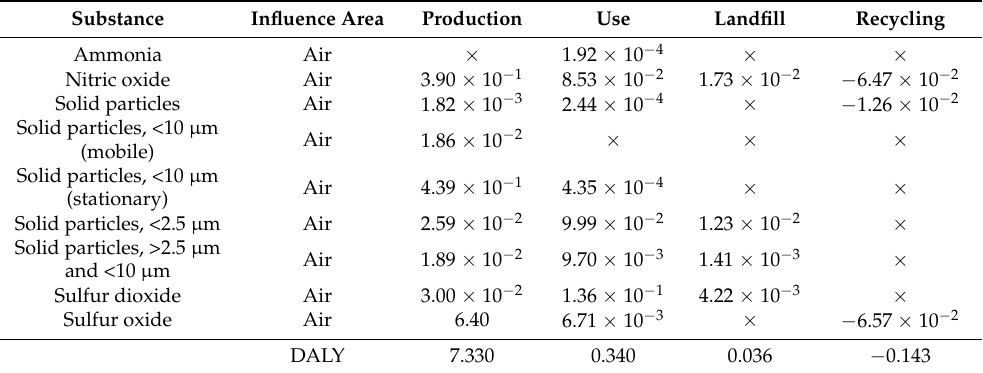
Table 5. Results of studies characterizing the environmental consequences for inorganic compounds causing respiratory diseases at particular stages of the life cycle of the Vestas V90, DALY [own research].